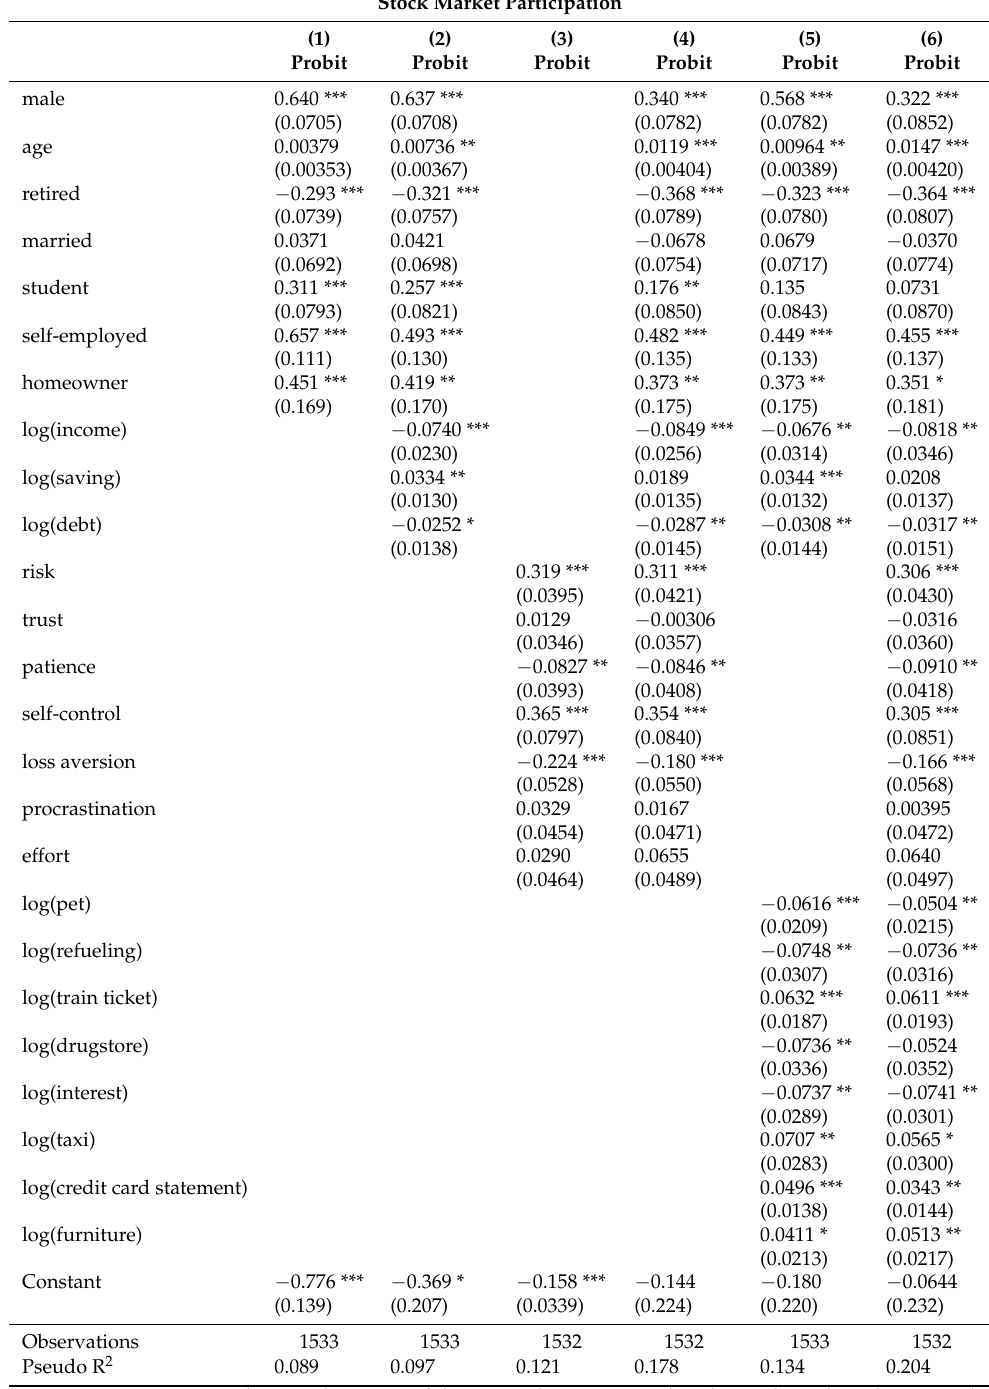
Table A10. Probit Regression of Stock Market Participation. Source: Own